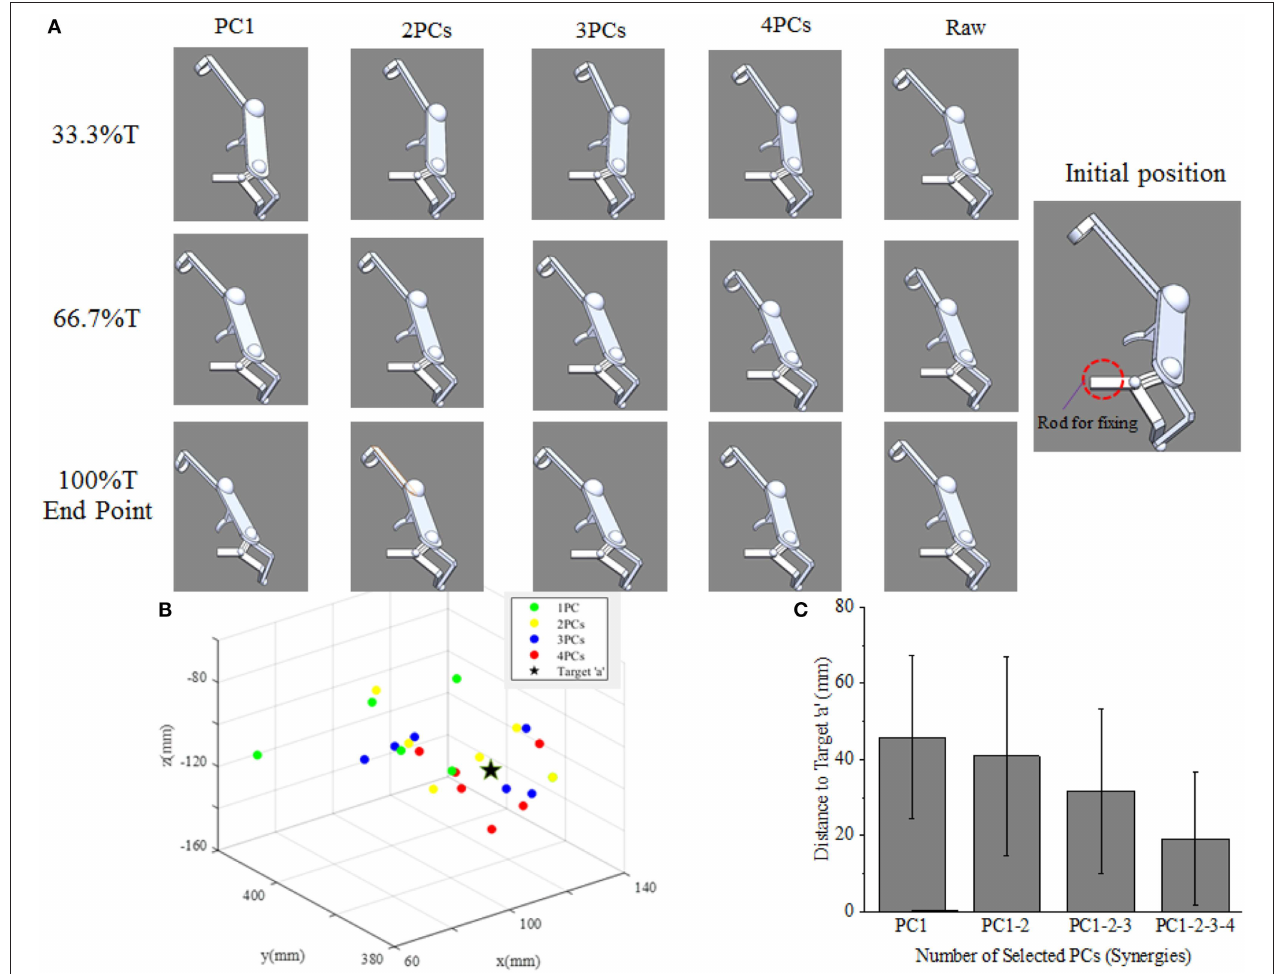
FIGURE 9 | (A) The upper limb assistive exoskeleton model driving by the first four PCs (synergies) at three specific time points of subject 5. (B) The calculated endpoint positions for subject 5 corresponds to reconstructions based on 1–4 PCs recruitment, with the true position of target “a” (location illustrated by Figure 2B ) shown as ⋆ . (C) Distance errors between calculated and actual target positions for all participants, and its changing trends as the recruited PCs (synergies)